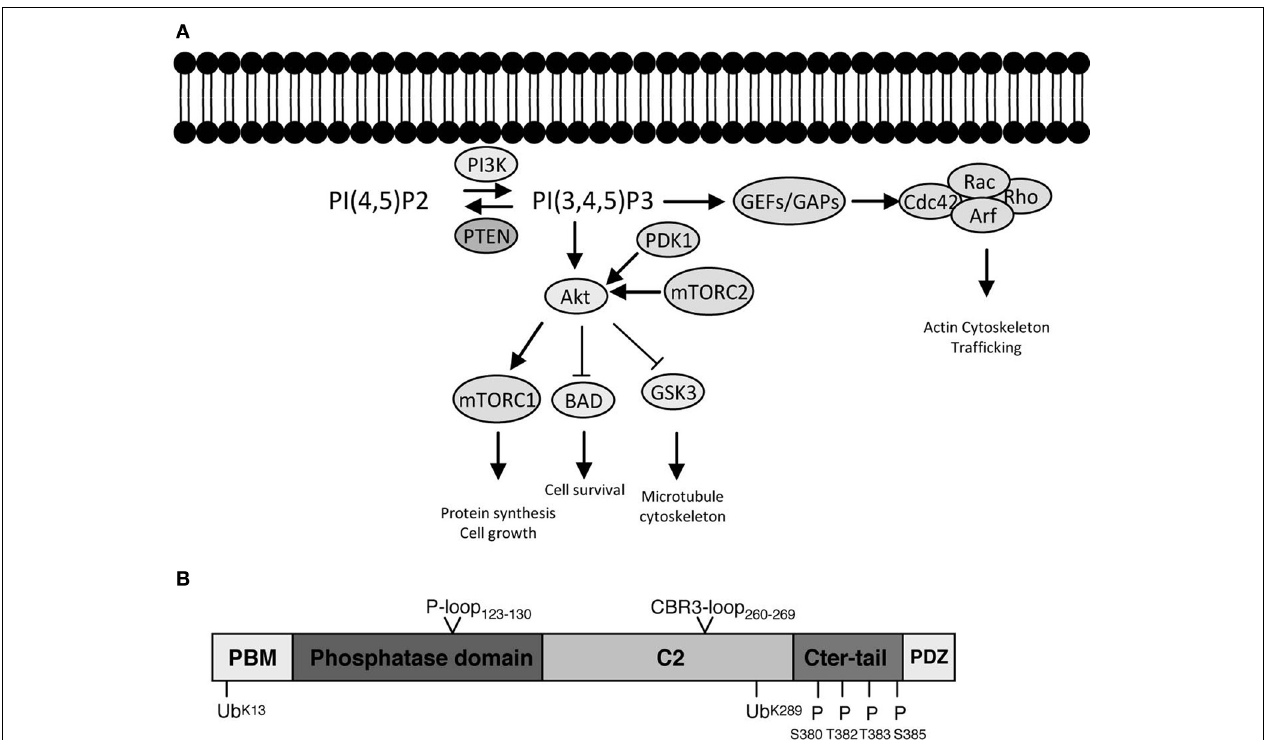
FIGURE 1 | PI3K signaling, PTEN, and downstream effector pathways. (A) One of the most prominent PIP3 effectors is the protein kinase Akt. Upon PI3K activation, Akt translocates from the cytosol to the membrane, where it binds PIP3 and is phosphorylated and activated by PDK1 (phosphoinositide-dependent kinase 1) and the rapamycin-insensitive complex containing mTOR (mammalian target of rapamycin), mTORC2. Akt is considered as a master regulator of cell growth and proliferation, as well as survival, by phosphorylating and regulating the activity of several proteins, which convey growth-factor-derived signals to cellular functions. For example, Akt phosphorylates and inactivates TSC2 (Tuberous Sclerosis Complex 2), which, in a complex with TSC1, is responsible for inhibition of RHEB (Ras Homolog Enriched in Brain). Thus, release of this inhibition results in activation of mTORC1 complex, which is important for promoting protein translation and accelerating cell growth in neurons. Its deregulation is associated with several neurodevelopmental disorders (Costa-Mattioli and Monteggia, 2013). Akt also phosphorylates and inactivates GSK3 (glycogen synthase kinase 3), a serine/threonine kinase that has been associated with a number of neuronal responses, particularly during neuronal development by regulating microtubule dynamics (Hur and Zhou, 2010). Besides Akt, PIP3 also provide a signal for membrane recruitment and activation of